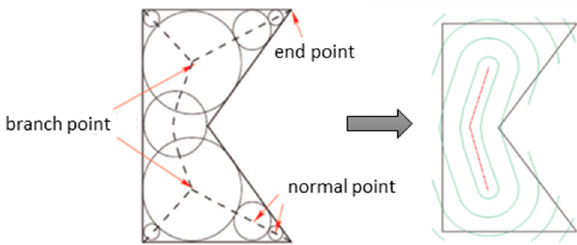
Figure 20. Schematic representation of the adaptive medial axis transformation planning method (adapted from [109]).